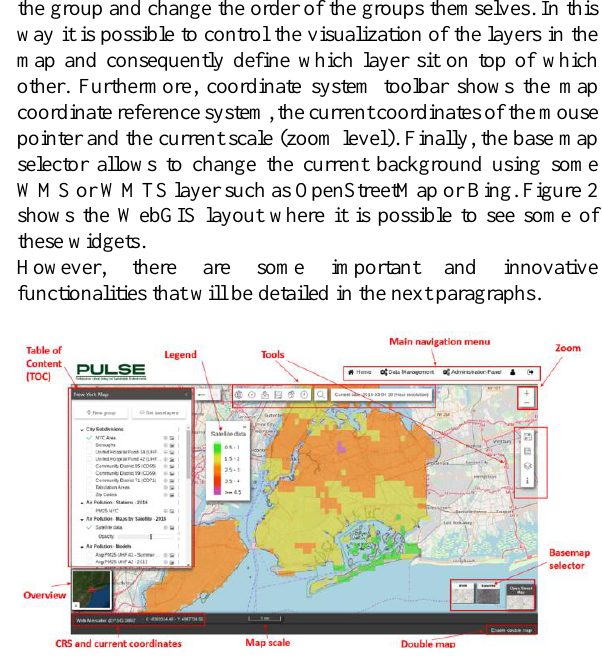
Figure 2. The WebGIS